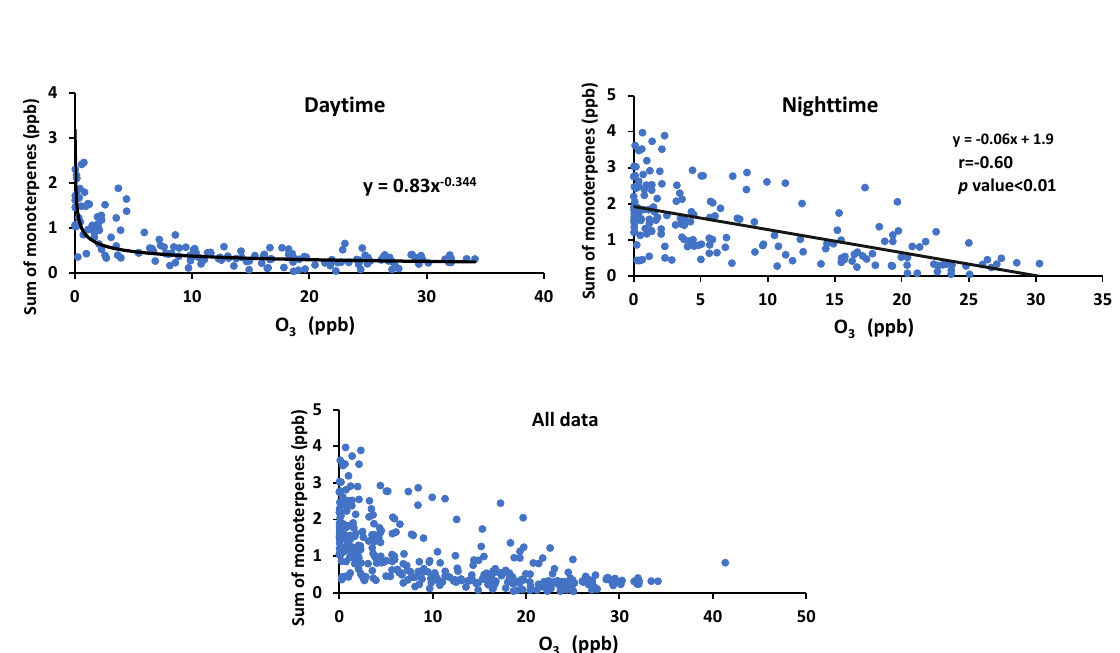
Figure 9. Sum of α -pinene, β -pinene, and Limonene versus ozone mixing ratio for daytime and nighttime and all